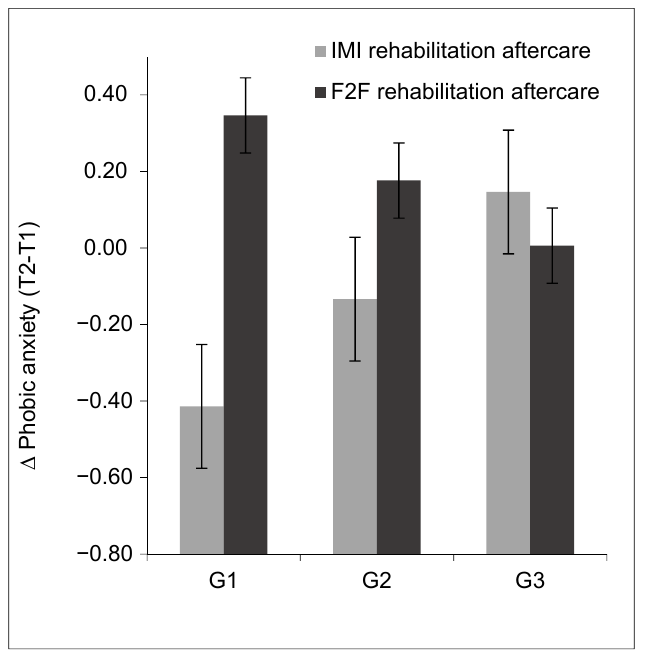
Figure 3 Figure 3. Visualization of the results testing age as a moderator of the short-term treatment change in phobic anxiety in the IMI and the F2F rehabilitation aftercare. G1, 27–49 years old; G2, 50–56 years old; G3, 57–67 years old. T1, baseline time point measurement; T2, 12 months follow-up time point